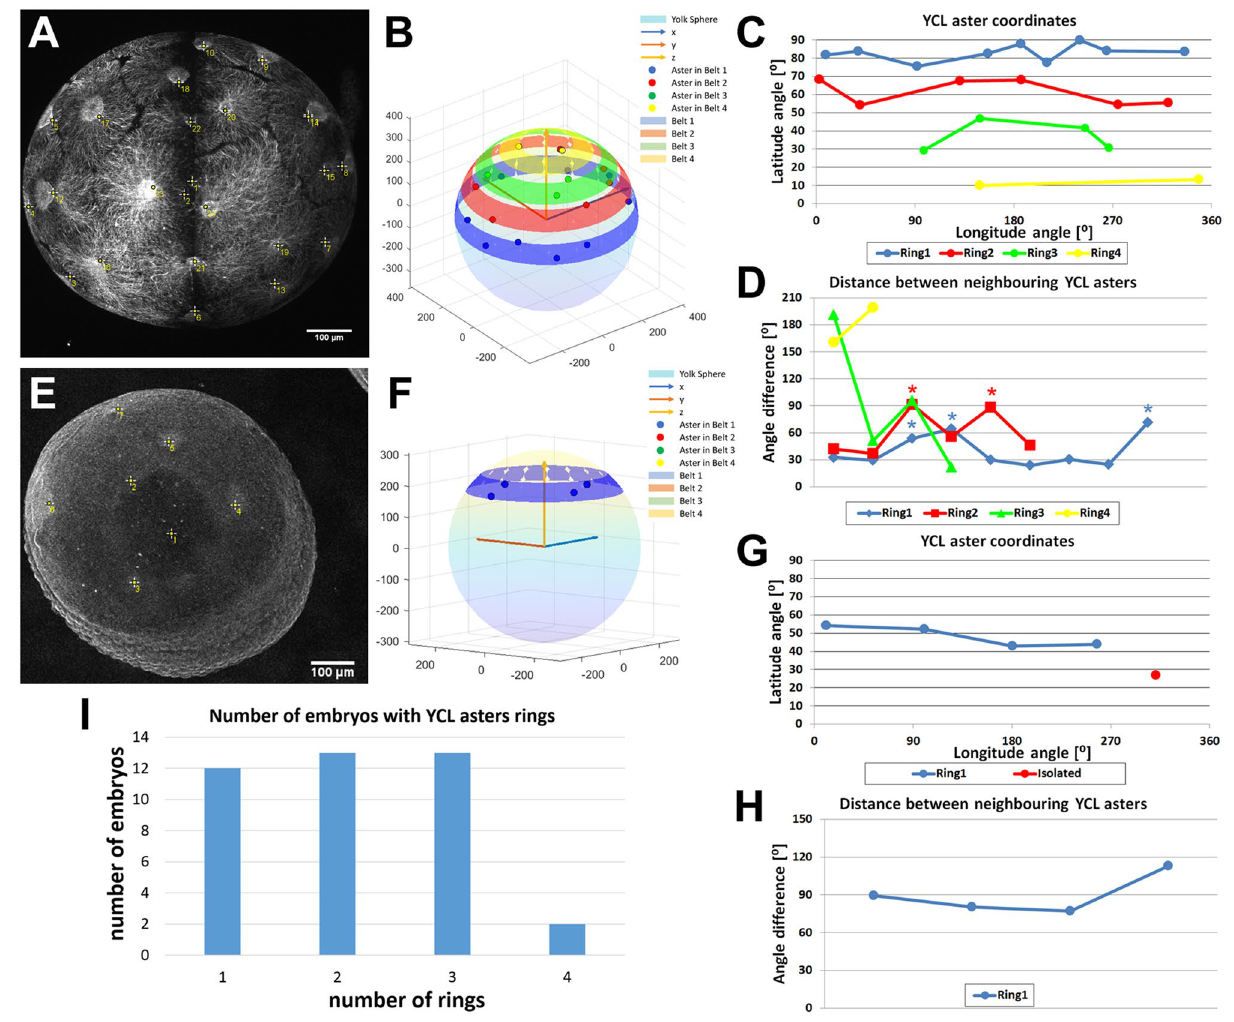
Figure 4. Analysis of the spatial YCL asters distribution in rings. ( A ) Maximum projection of a dclk2-GFP embryo where 22 YCL asters can be identified (yellow crosses) distributed in four rings. Identifiers 1 and 2 correspond to the vegetal pole and to the center of the embryo, respectively. ( B ) Projection of the aster position over the sphere modeling the yolk. Asters belonging to the same ring are represented by dots of the same color, rings are highlighted as belts at the calculated latitude. ( C ) YCL asters latitude (polar angle). YCL asters are not randomly located, but they group at four different latitudes (rings) (blue, red, green, and yellow). ( D ) Azimuthal angle differences between neighboring asters in rings 1 (blue), 2 (red), 3 (green), and 4 (yellow). Asters in this embryo are equidistant in 6/9 cases in ring1 and 4/6 cases in ring2. Cases with higher distances are marked with asterisks. ( E – H ) The same analysis for an embryo with only one YCL asters ring. Here 5 YCL asters can be identified: 4 asters distributed around 360°, and one in the vegetal pole. Each aster is highlighted with a yellow cross in Fig. 3E. Identifiers 1 and 2 correspond to the vegetal pole and to the embryo center, respectively. For this particular case, asters are equidistant ( H ). ( I ) Plot of the distribution of YCL asters in 1, 2, 3, or 4 rings. The analysis was performed on 40 embryos. ( B , F ) Created with MATLAB R2020b (https:// www. mathw orks. well-known MTOC is the centrosome, used by cells during mitosis. However, in many non-dividing cells, the organization of the MTs is imparted by non-centrosomal MTOCs (nc-MTOCs), whose composition is rather unknown 45–48 . Nc-MTOCs are thought to contain a shorter list of proteins compared to centrosomal MTOCs, amongst which there have to be MT minus-end and plus-end interacting proteins recruited for growing MTs tips 49,50 . Therefore, to give YCL asters a molecular identity as MTOCs, we analysed the expression of two dif- ferent proteins: EB3 and γ-tubulin, which complements the results on β-tubulin expression previously shown. EB3-mCherry mRNA was injected at one-cell stage dclk2-GFP embryos to label MT plus-ends 51 . Its recruit- ment into growing MT tips was used as an indicator of the polymerization process during plus-end growth occurring at the yolk MTOCs. Thus, e-YSN centrosomes were marked by EB3 comets as newly polymerized plus ends emanate from them 52 and extended further down along growing MTs (Fig. 5A and Video S8). EB3 local- ized to e-YSN centrosomes and the mitotic spindle throughout mitosis, as shown in Video S8. To counterstain nuclei, DAPI staining was performed on fixed 512–1000-cell stage dclk2-GFP embryos, previously injected with